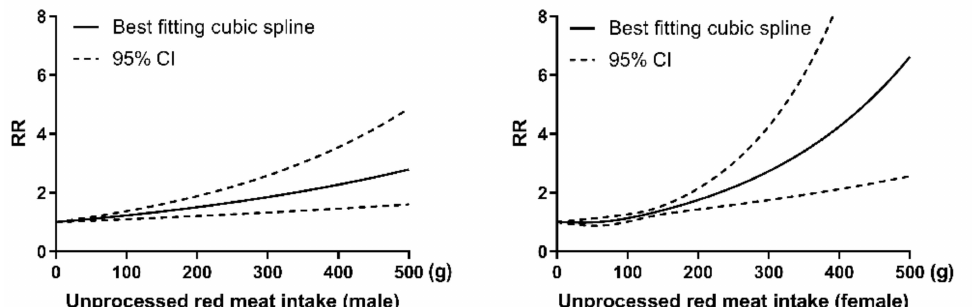
Figure 2. Dose–response relationship between consumption of PRM (male: P linearity = 0.18; female: P non-linearity < 0.01), URM (male: P linearity = 0.40; female: P non-linearity = 0.61) and risk of T2DM.